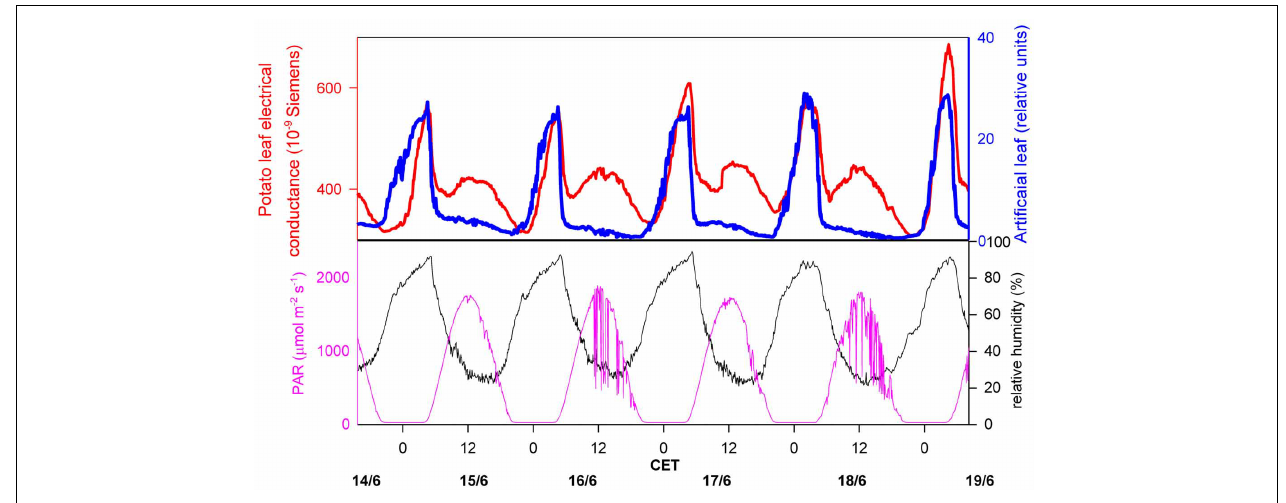
FIGURE 1 | Measurement of leaf wetness on a potato field, comparing an artificial leaf (blue line; Campbell leaf wetness sensor 237, Campbell Scientific, Logan, UT, USA), and a leaf wetness sensor directly attached to a potato leaf (red line,